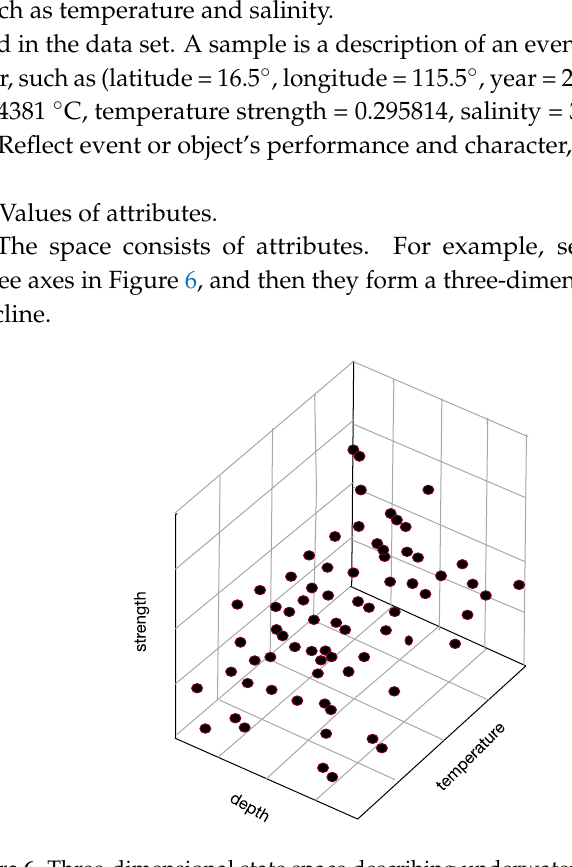
Figure 6. Three-dimensional state space describing underwater thermocline.